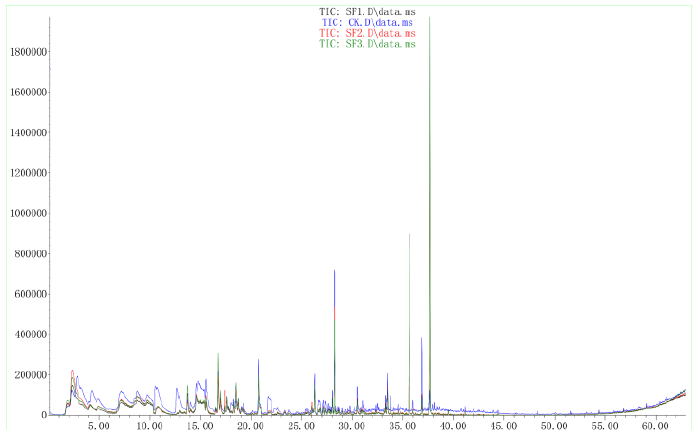
Figure 5. GC–MS results of volatile organic compounds produced by Xenorhabdus bovienii . CK is the blank control and SF1, SF2, and SF3 are three replicate samples in the experimental